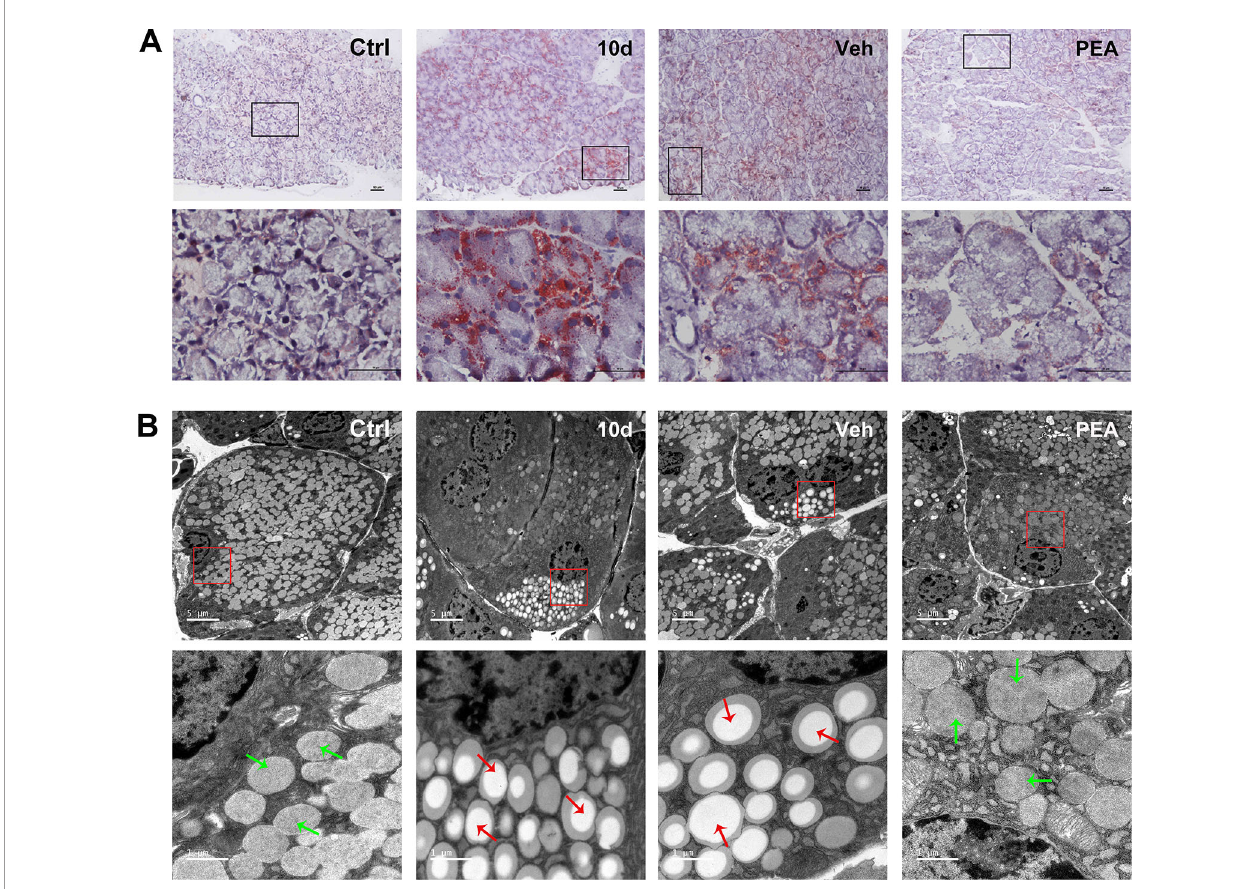
FIGURE 3 | PEA treatment reduced lipid accumulation in SD-induced mice LGs. Oil red O staining results indicated that PEA reduced lipid deposition in SD-induced mice LG (A) , scale bars: 50 m m. Ultrastructural analysis under transmission electron microscopy revealed that PEA decreased lipid droplets accumulation close to the LG acinar cell nucleus (B) . Lipid droplets (red arrows), secretory granules (green